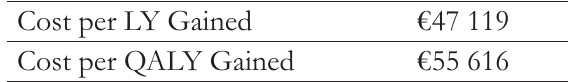
Table 7. Incremental Cost per LY/QALY Gained of Ruxolitinib vs